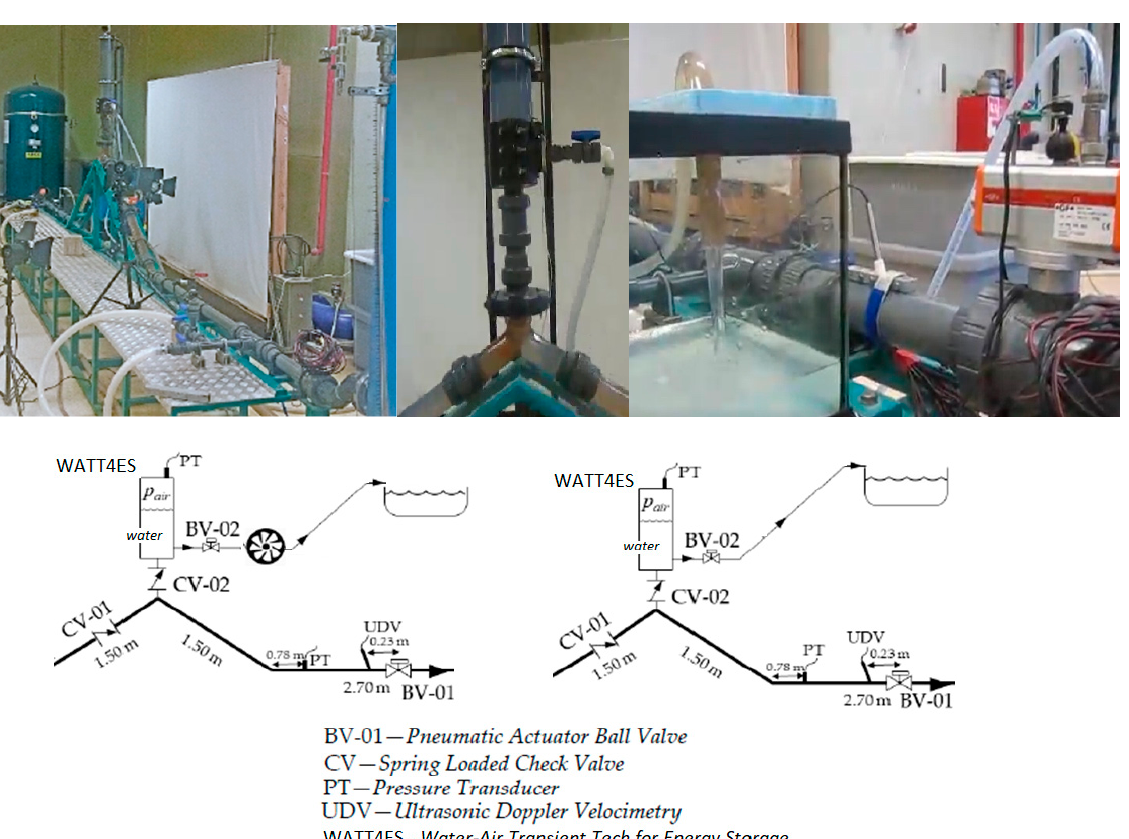
Table 1. Energy power estimation in the WATT4ES.